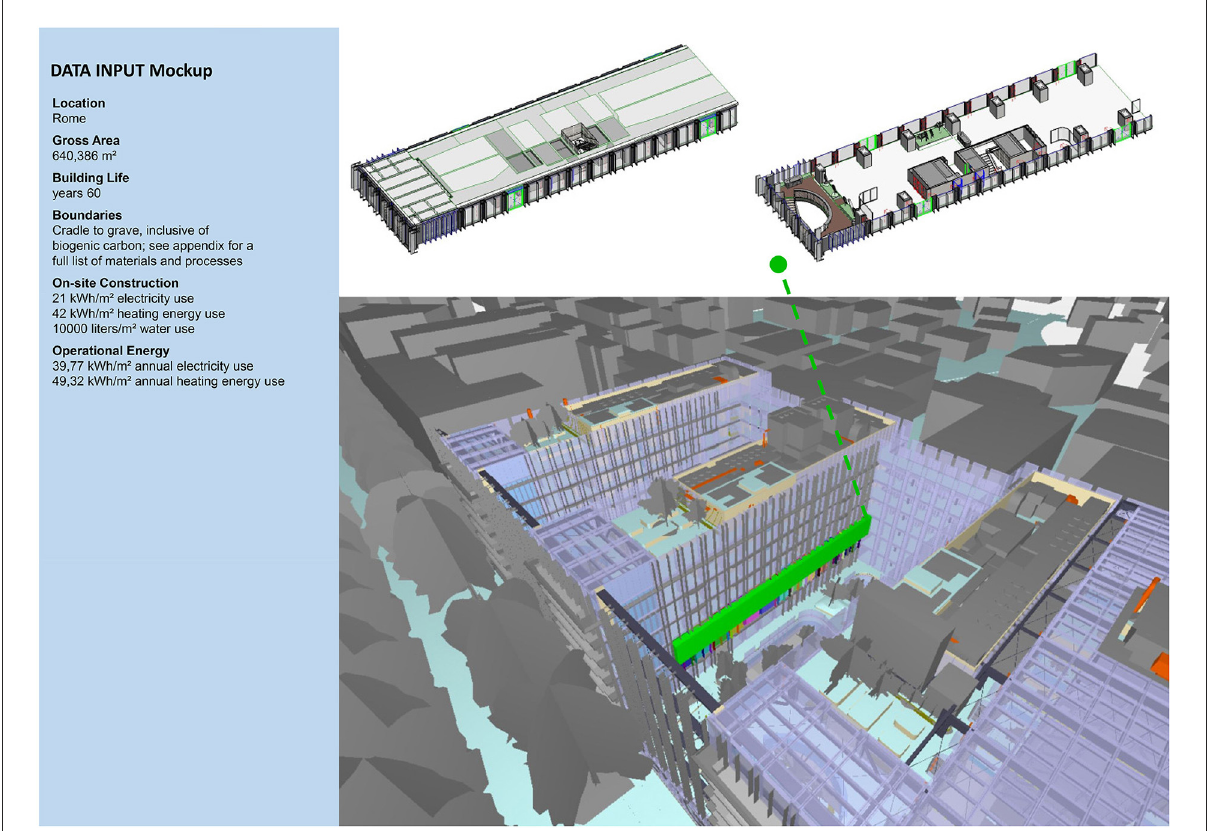
FIGURE3 Overview of the digital mock-up (LOD C) of an office space that has been analyzed within this experimental work.